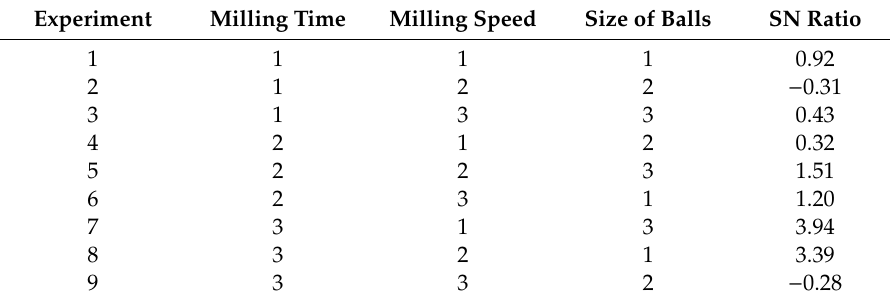
Table 3. Signal to noise ratio (S / N) for each